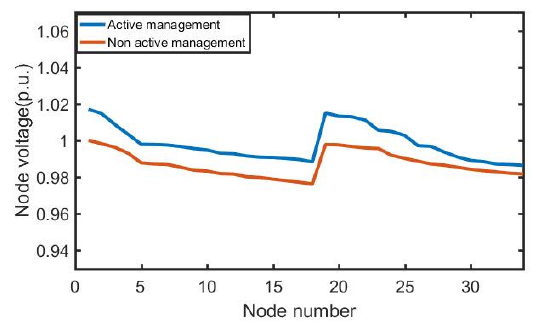
Figure 9. Nodal voltage curve.